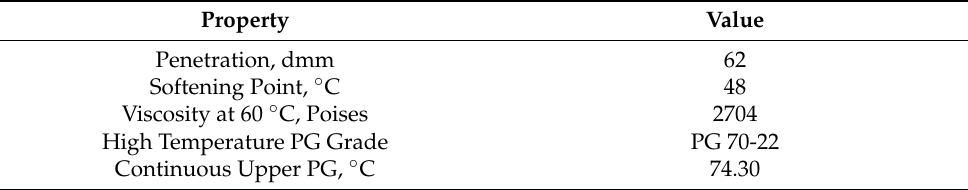
Table 2. Basic properties of binder.